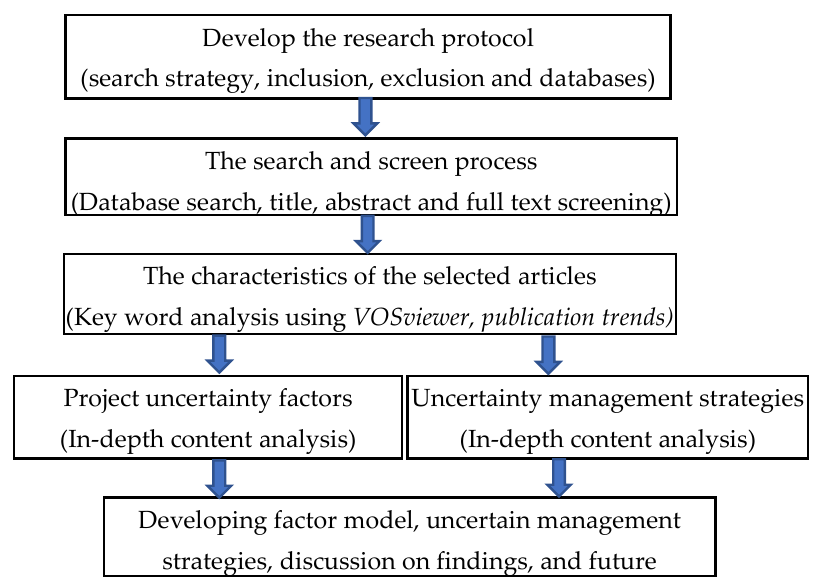
Figure 1. The steps of the research.